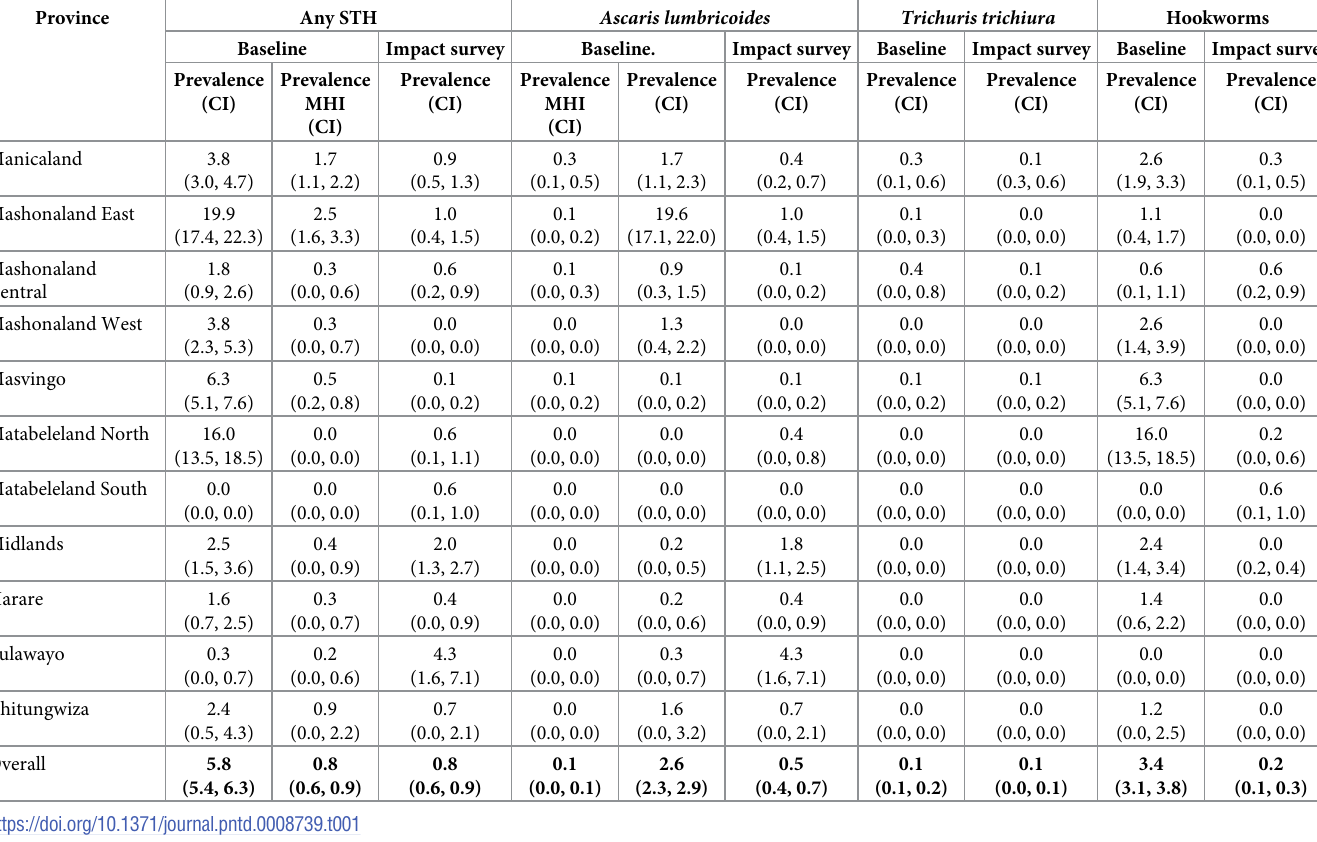
Table 1. Prevalence of STH and prevalence of moderate and heavy intensity STH infection (MHI) by species by province at baseline survey (2010–2011) and at impact survey (2018–2019).